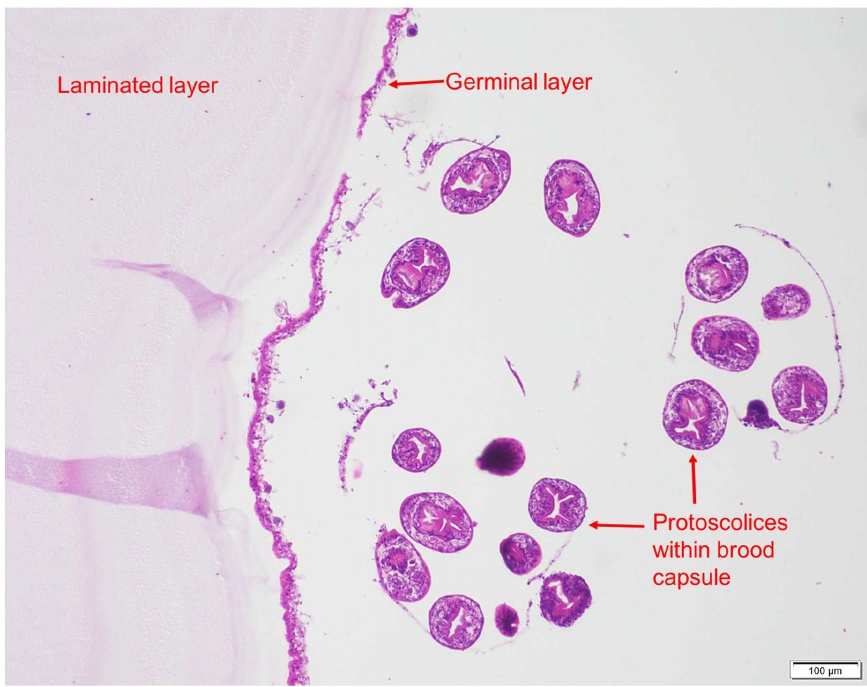
Figure 3. Protoscolices within cyst. Photo: C. Constantinoiu